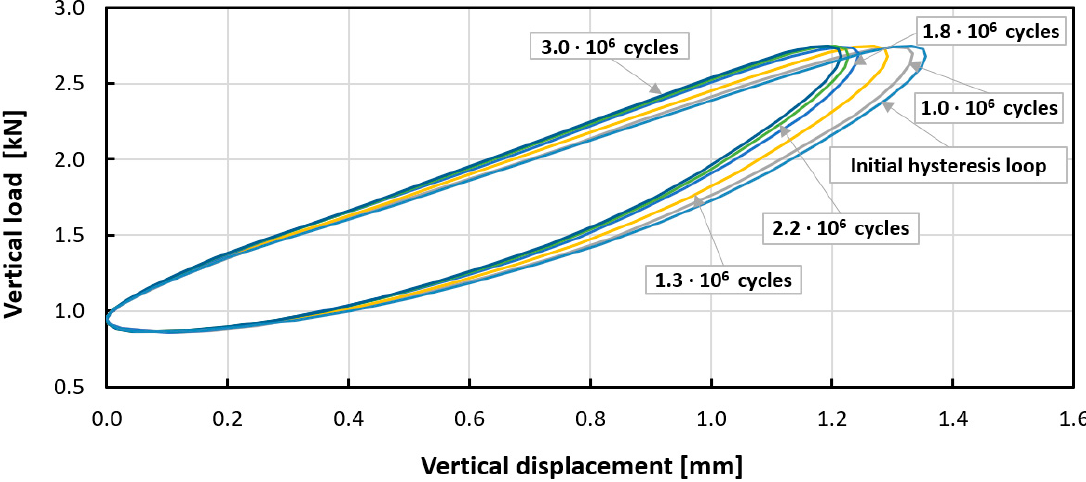
Figure 5. Experimental curves (specimen 3) showing the effect of the number of load cycles on the dynamic mechanical response (C dyn ), cyclic hardening of Mat A.